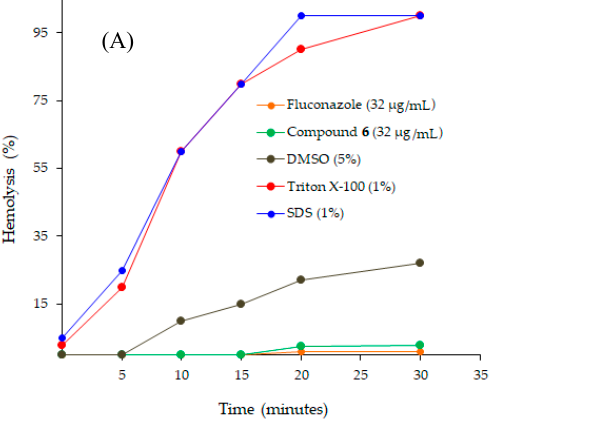
Figure 7. ( A ) Comparison of hemolysis by compound 6 (green curve) and fluconazole (orange curve), Table S4; ( B ) Time-kill curve of compound 6 against Candida glabrata (ATCC 2001), Table S3.